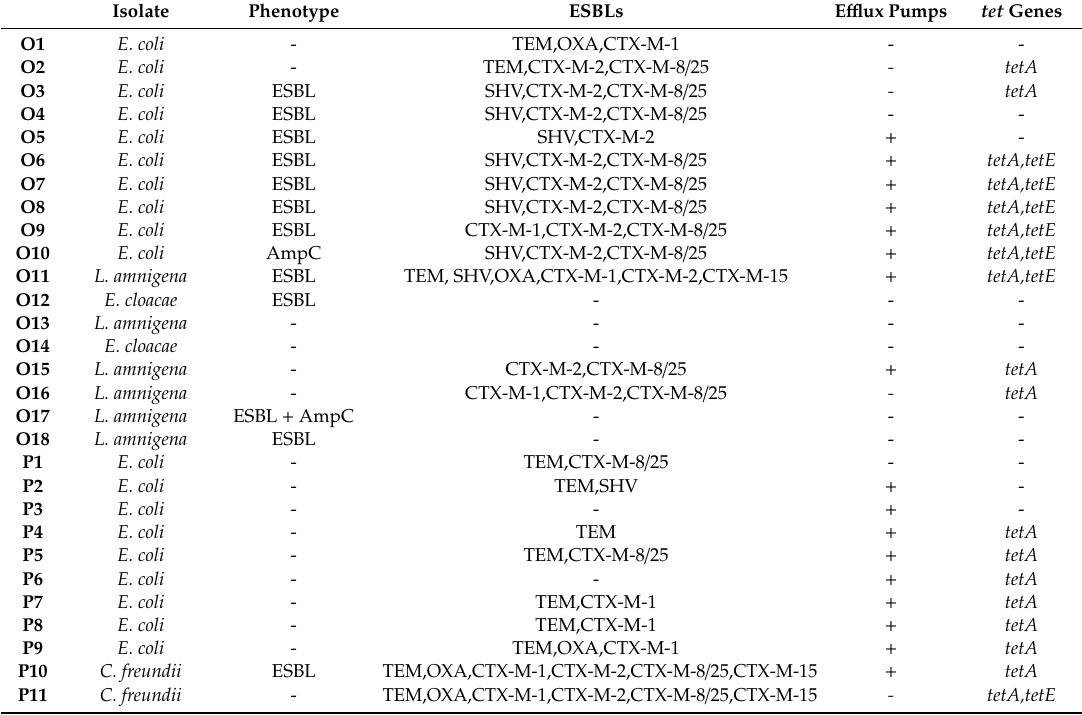
Table 5. Characterization of antibiotic resistant coliform bacteria isolated from